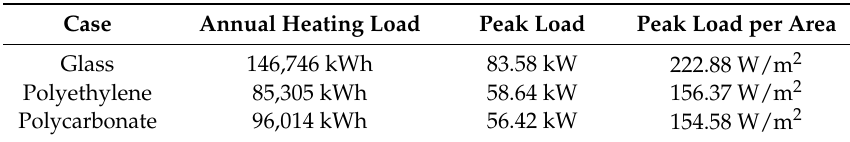
Figure 8. Heating load of each case. Table 5. Simulation results of each case.